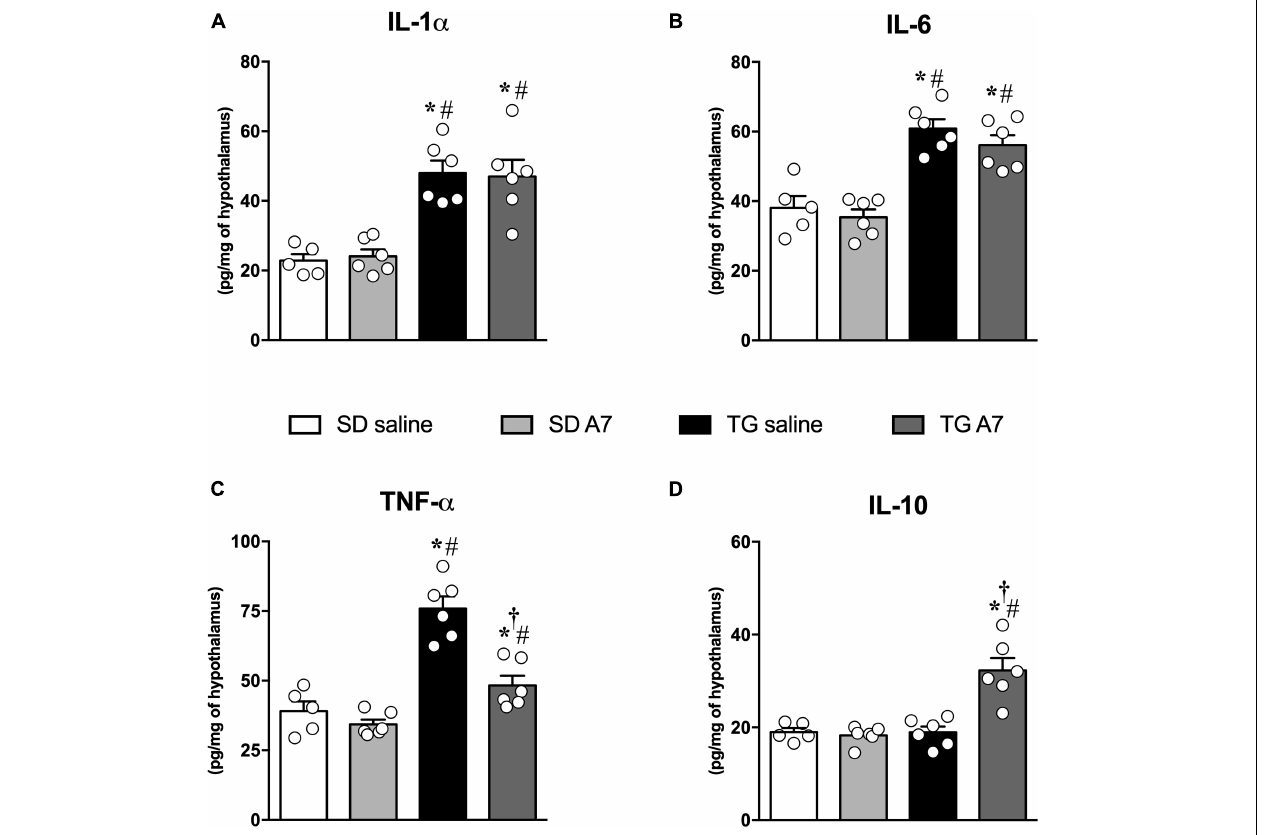
FIGURE 2 | Concentrations of pro-inflammatory cytokines in the hypothalamus in SD and hypertensive rats treated with Ang-(1-7) ICV. interleukin-1 alpha (IL-1 α ) (A) , interleukin-6 (IL-6) (B) , tumor necrosis factor-alpha (TNF- α ) (C) and anti-inflammatory cytokine, interleukin-10 (IL-10) (D) were measured using commercially available antibodies by enzyme-linked immunosorbent assay (ELISA). Results are expressed as mean ± SEM. n = 5 or 6. * p < 0.05 vs. SD saline; # p < 0.05 vs. SD A7; † p < 0.05 vs. TG saline (One-way ANOVA followed by Newman-Keuls post hoc